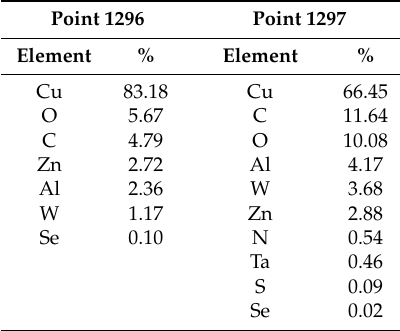
Figure 14. Dispersive energy spectroscopy spectra analyzed in the points of Figure 13. Table 11. Mass of chemical elements at the points analyzed in Figure 13.